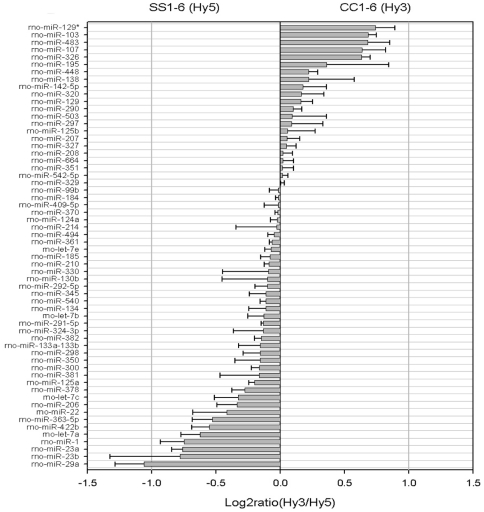
Over-expression of some microRNAs is observed in IPGR SKM samples over the control animals.Differential expression profile of sixty micro-RNAs that bind to the Chips in LNA-based microarray analysis (Exiqon miRNA-vol 8.1) of male rat SKM micro-RNA enriched samples isolated from CMCP (CC1-6) and SMSP (SS1-6) animals. CC1-6 samples are labeled with Hy3 and SS1-6 by Hy5 dyes. Log2ratio of Hy3 by Hy5 is plotted against every bound microRNAs. Sample size was N = 3 and 10 different spike-in controls have been used for the experiment as internal control.